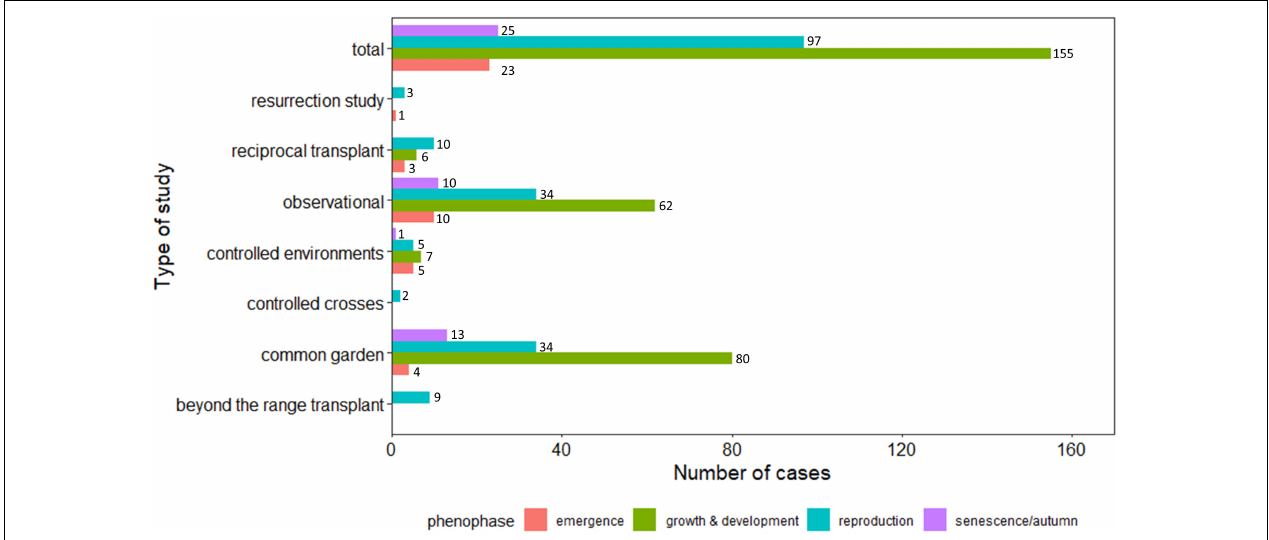
FIGURE 1 | Frequency of each type of study conducted across each phenophase, including emergence (red), growth and development (green), reproduction (blue), and senescence or autumn phenology (purple). Studies were considered observational or experimental, the latter including resurrection studies, reciprocal transplants, controlled environments (i.e., greenhouse or growth chambers), controlled crosses, common gardens, or beyond the range transplants. Note that values here represent cases, or separate datasets, such that a single publication could include multiple types of cases (e.g., data from natural populations, a reciprocal transplant experiment, and a controlled environment greenhouse